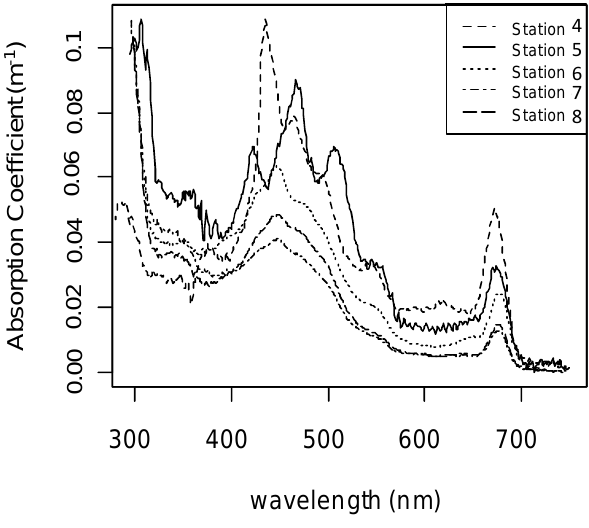
Fig. 2. The spectral percentage of light transmitted in the UVB, Fig. 3. Absorption spectra coefficients for the phytoplanktonic com- UVA and PAR bands of the quartz and borosilicate bottles used in ponent of particles observed at the surface water (5m) along the the metabolism measurements. stations Figure 3. Absorption spectra coefficients for the phytoplanktonic component of particles observed at the surface water (5m) along the stations sampled. Figure 2. The spectral percentage of light transmitted in the UVB, UVA and PAR bands of the quartz and borosilicate bottles used in the metabolism measurements.